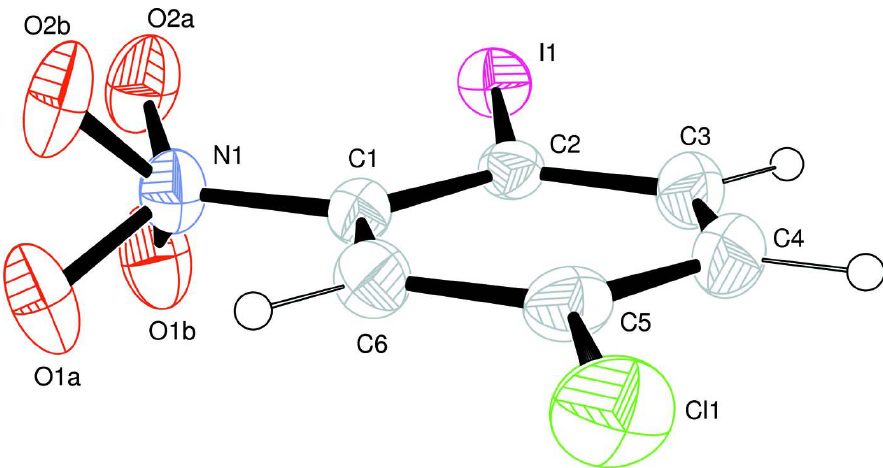
Figure 1 View of the molecular structure of (I) with displacement ellipsoids drawn at the 30% probability level. H-atoms are shown by spheres of arbitrary